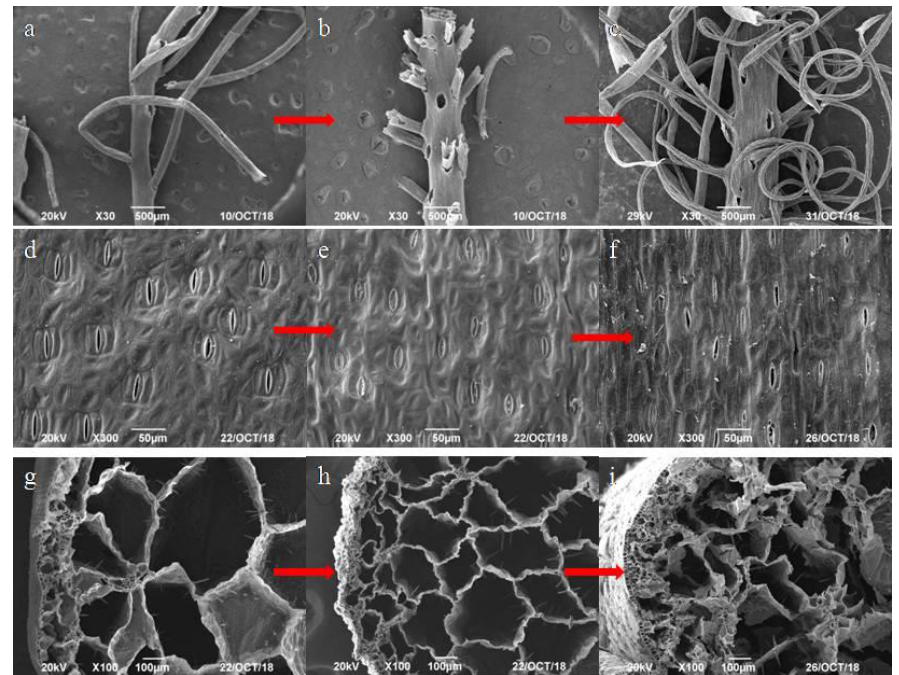
Figure 3. SEM images of (a) roots before experiment, (b) roots in karst water with 60 mg/L Ca 2+ , (c) roots in karst water with 80 mg/L Ca 2+ , (d) leaves before experiment, (e) leaves in karst water with 60 mg/L Ca 2+ , (f) leaves in karst water with 80 mg/L Ca 2+ ,(g) stems before experiment, (h) stems in karst water with 60 mg/L Ca 2+ , (i) stems in karst water with 80 mg/L Ca 2+ .